Question: Is the quantity shown trending increasing or decreasing?
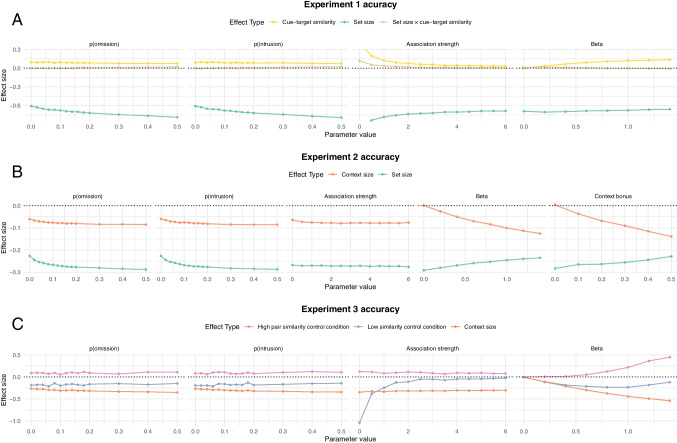
Answer: increasing